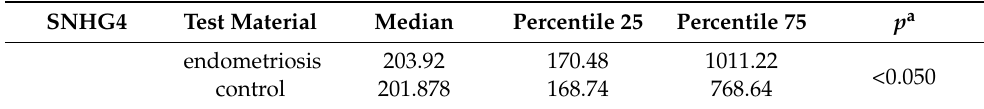
Table 2. Expression of SNHG4 in endometriosis patients and control.